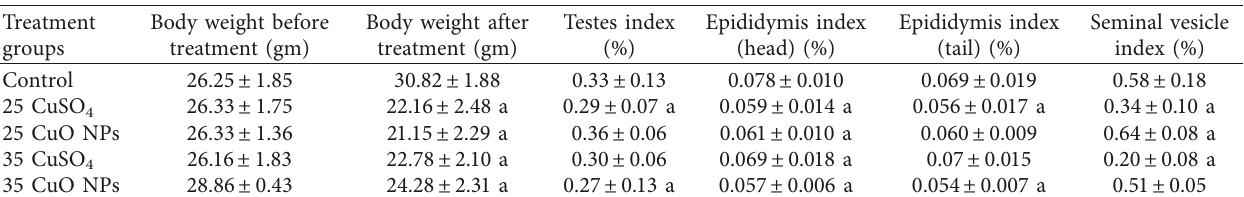
Data represent the mean ± standard deviation (SD). A: significant difference at P ≤ 0 . 05 compared with the